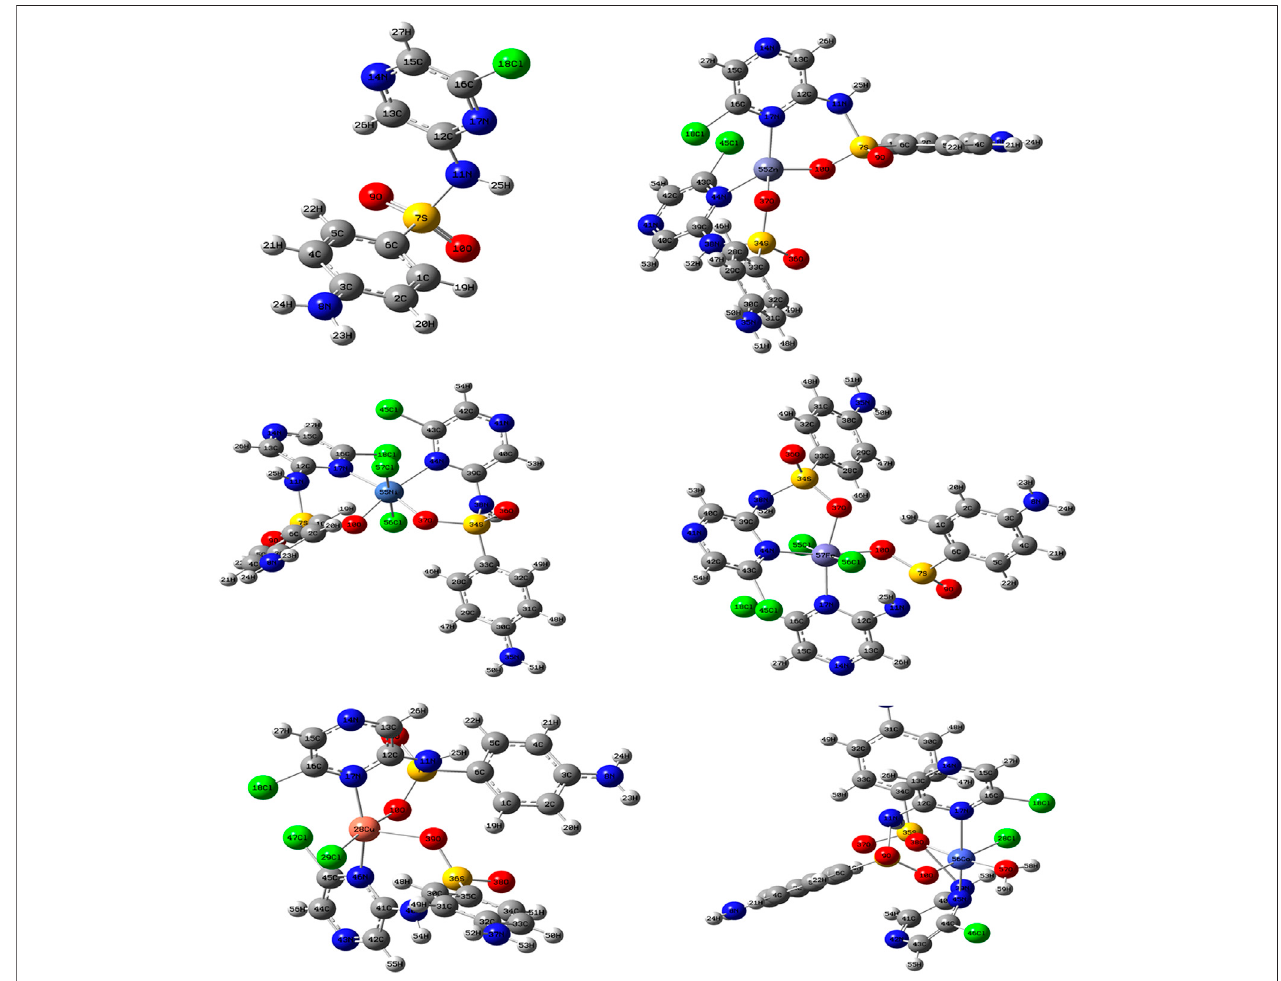
FIGURE 5 | The optimized geometry with the numbering system of the free SCZ ligand and the fi ve metal complexes.